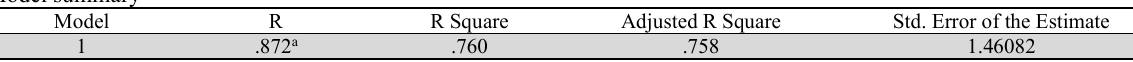
Model summary Source: Primary data collected.